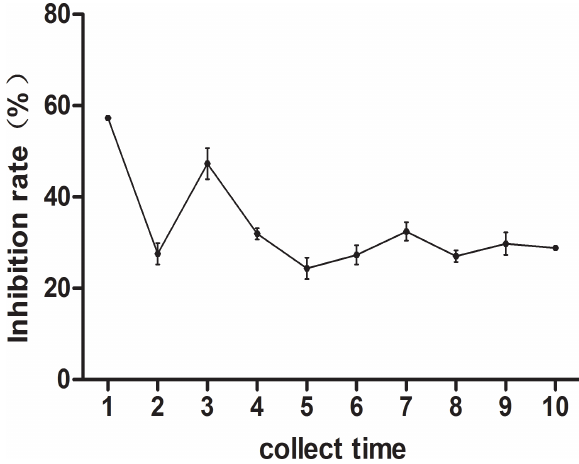
Figure 4: Temporal changes in the inhibition effect of M. halliana flowers during blooming on α -